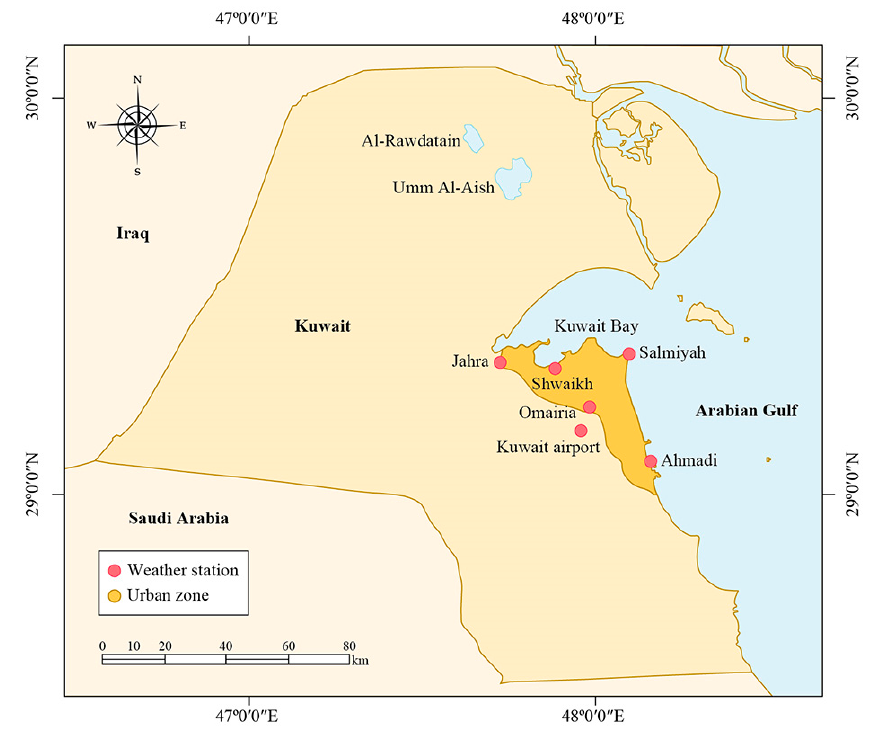
Figure 1. Study Area and the Location of Major Fresh Groundwater Aquifers.